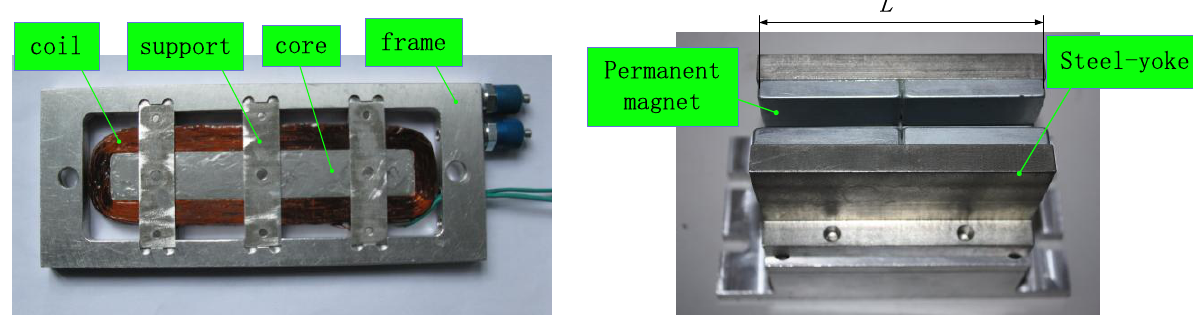
Figure 1. Structure of the Lorentz motor.